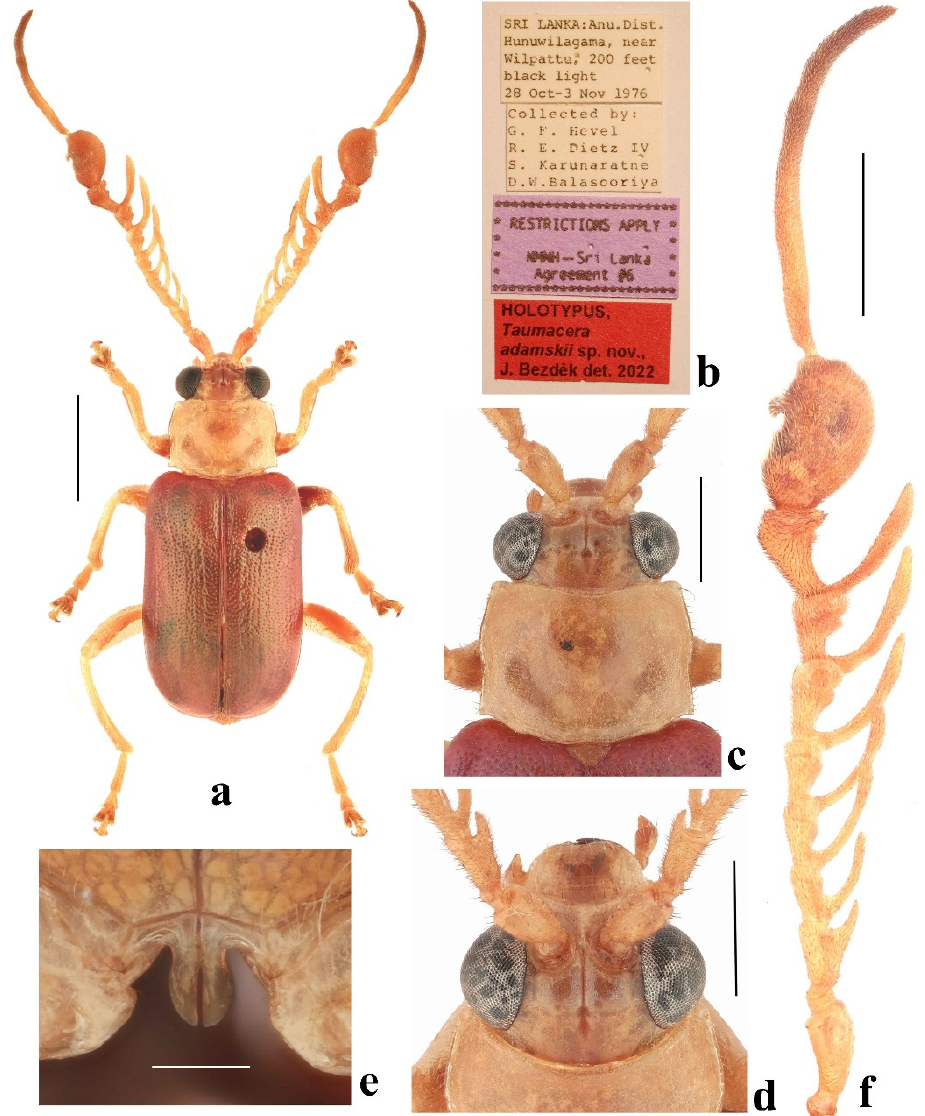
Figure 12. Taumacera adamskii sp. nov., holotype: ( a ) holotype, male; ( b ) labels; ( c ) head and pronotum, dorsal view; ( d ) head, frontal view; ( e ) male metasternal process; ( f ) left antenna. (Scale bars: ( a ) = 2 mm, ( c , d , f ) = 1 mm, ( e ) = 0.3 mm, ( b ) not to scale).